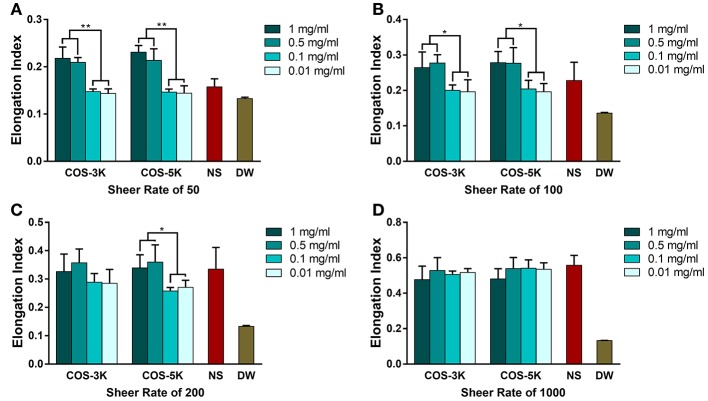
Deformability of RBC detected by a laser-diffraction Ektacytometer system under shear rate of 50 (A), 100 (B), 200 (C), 1,000 (D) with the presence of COS with different concentration. NS, normal saline; DW, diluted water. *p < 0.05; **p < 0.01.